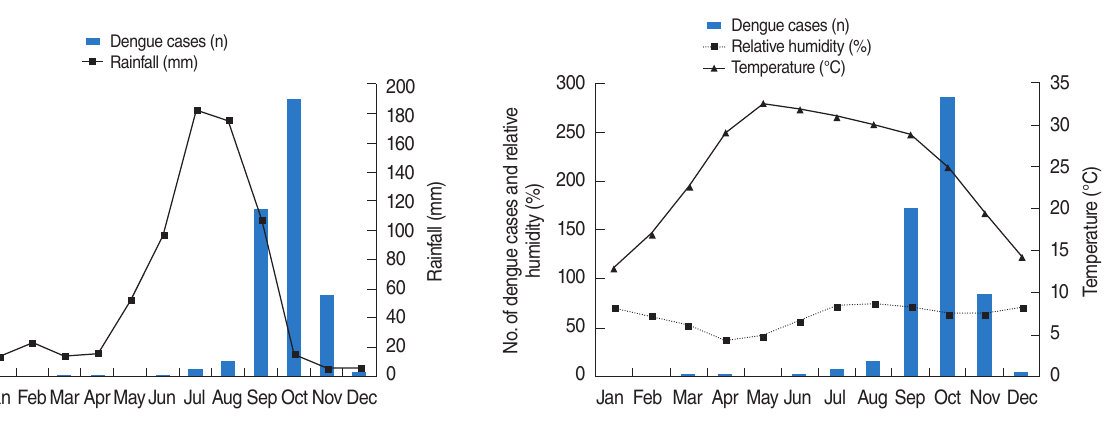
Figure 2. Average number of dengue cases, temperature, and rel- ative humidity by month from 1997 to 2015.